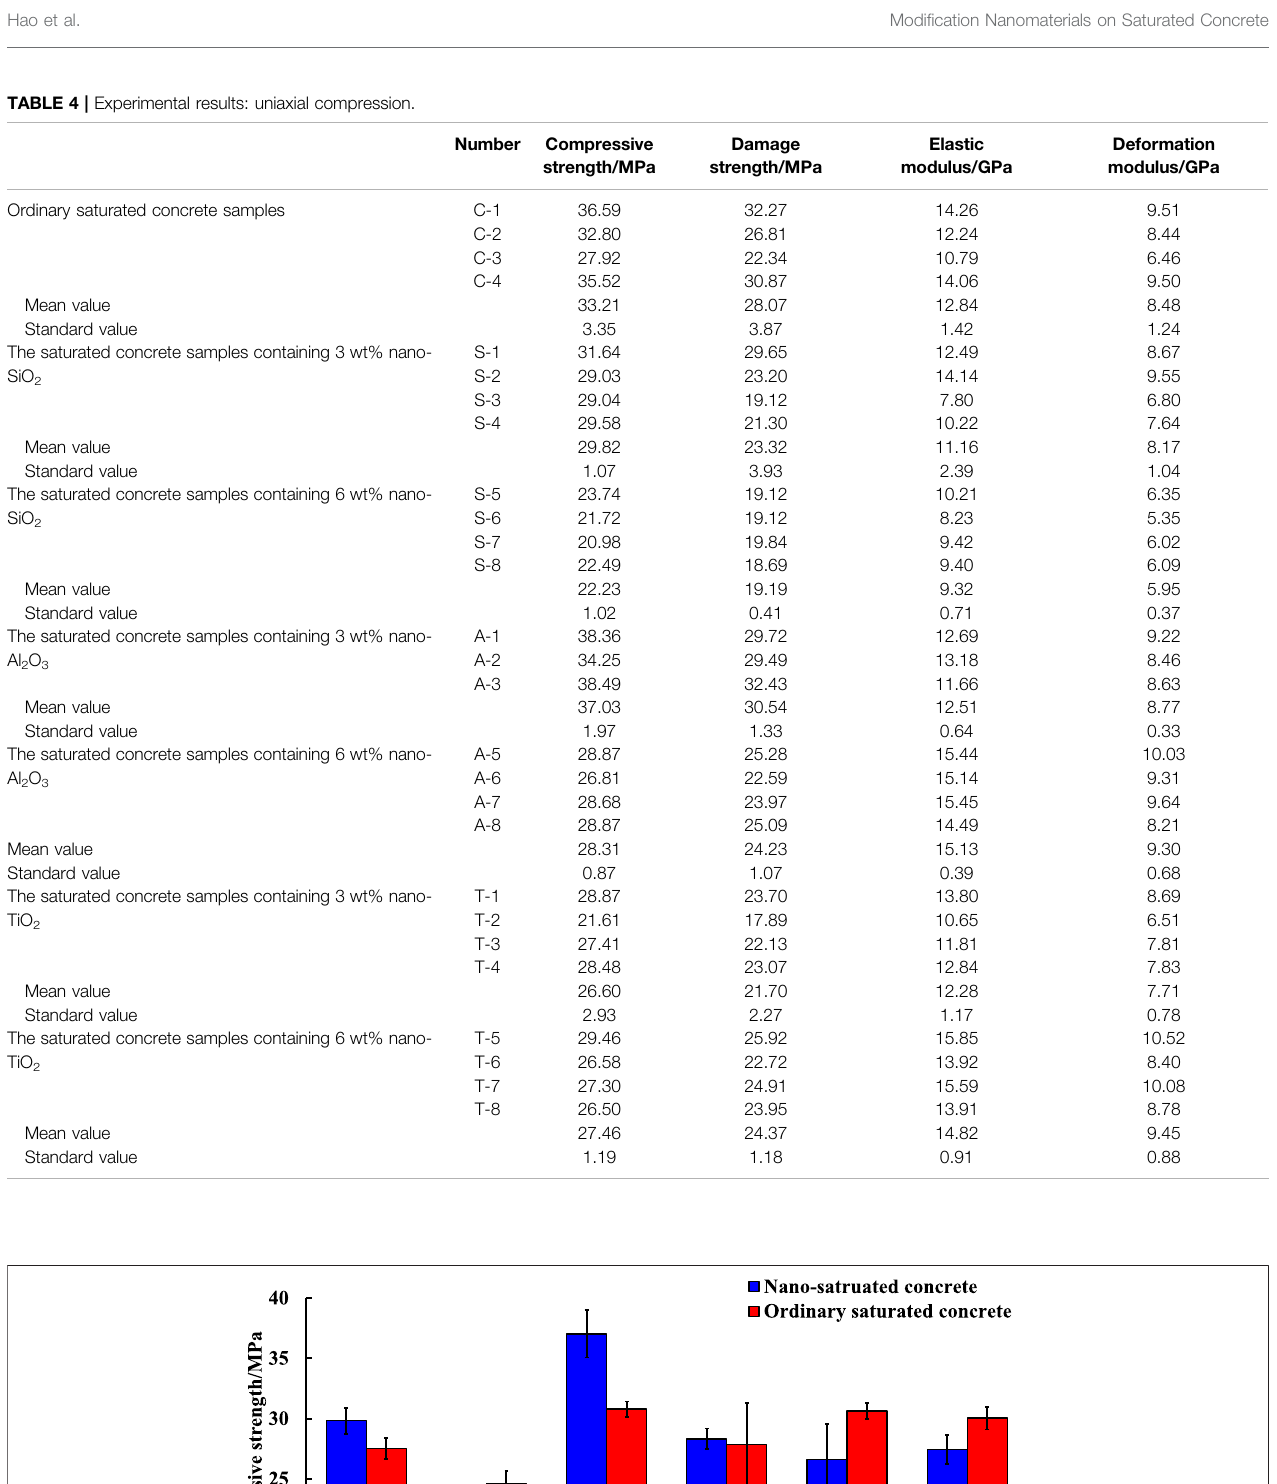
TABLE 4 | Experimental results: uniaxial compression.